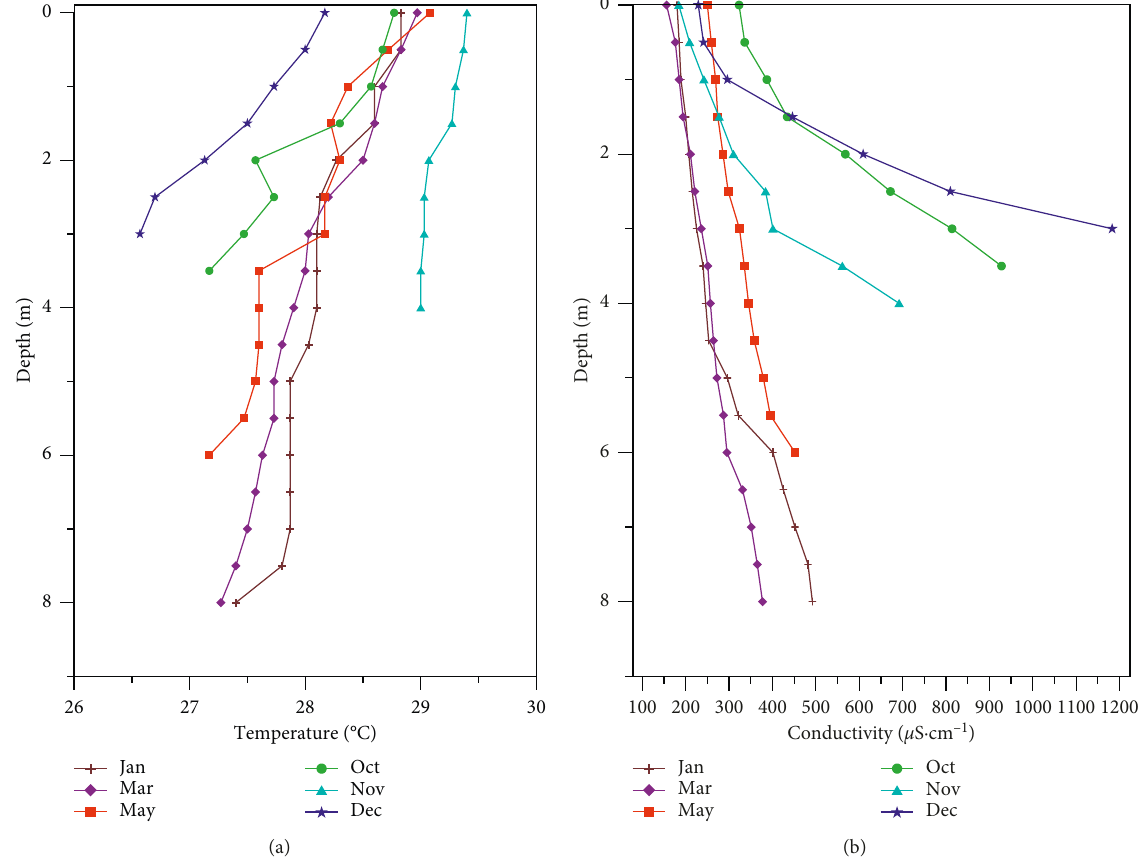
Figure 3: Vertical profiles of temperature and